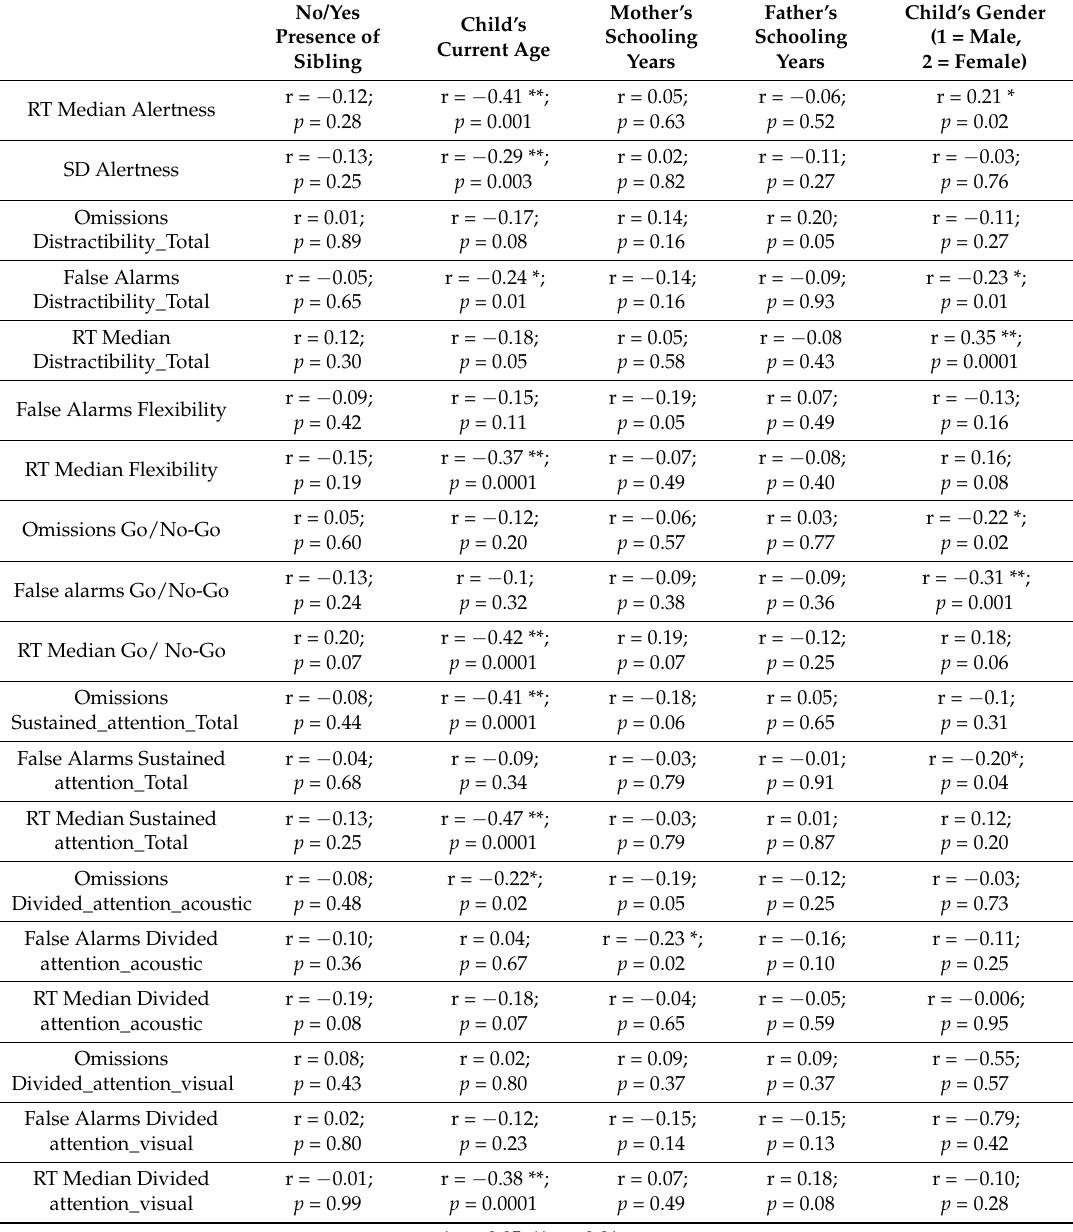
Table 5. Pearson’s correlations between the examined variables and each attentional functioning scale.